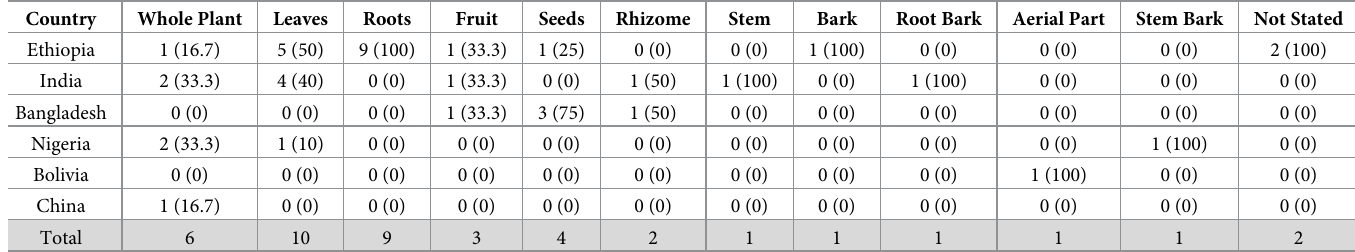
Table 1. Plant part used for rabies by country (N, %).